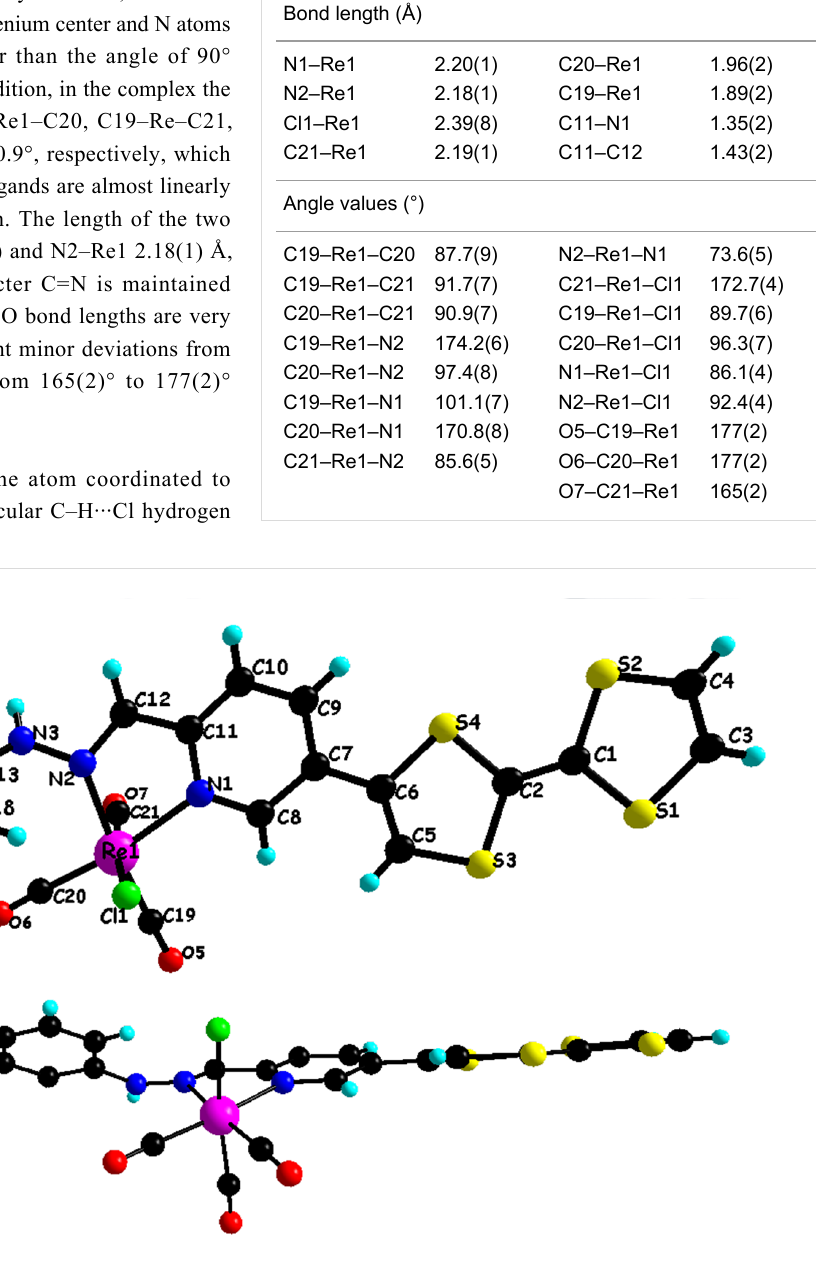
Figure 9: Crystal structure of complex 3 with atom numbering scheme (top) and a side view of the molecule (bottom). Water molecules are omitted for clarity.